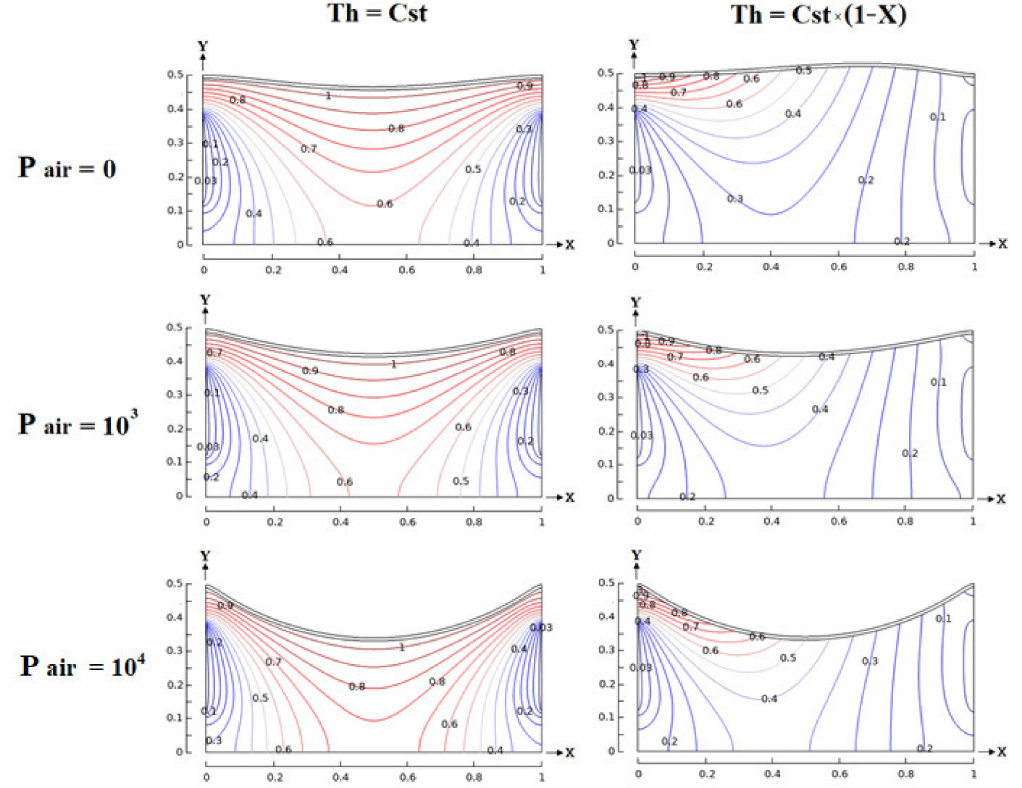
Figure 8. Combined effects of hot temperature distribution and air pressure on nanofluid tempera- ture